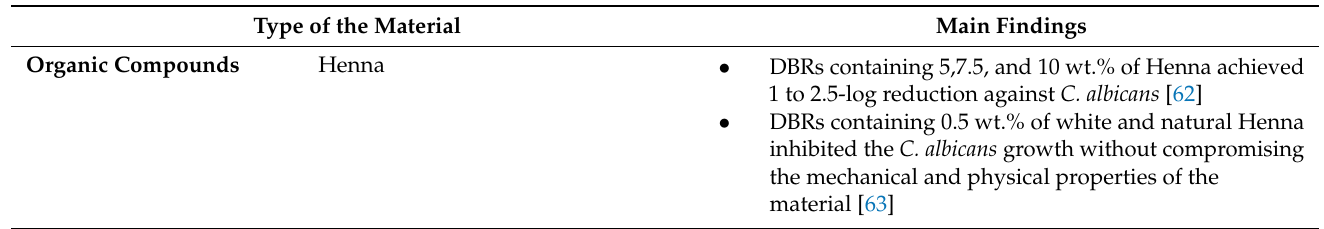
Table 1. Summary of the bioactive agents incorporated into denture based resin (DBR) materials to minimize the growth of denture stomatitis-related pathogens.